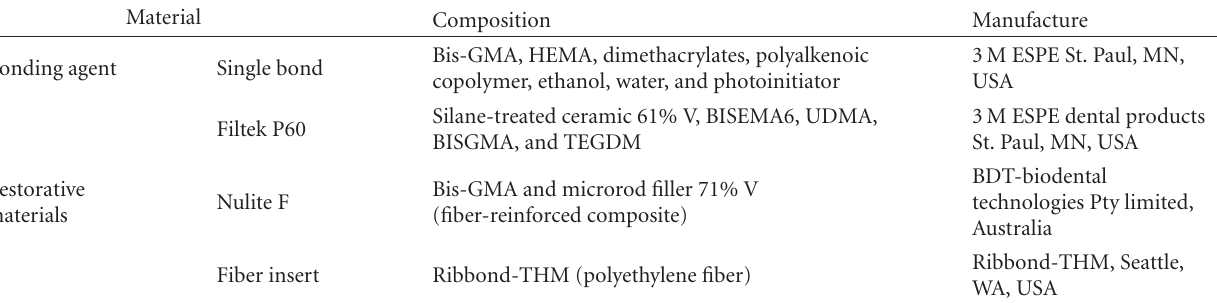
Table 1: Chemical composition and manufacture of bonding agent and restorative materials used in this